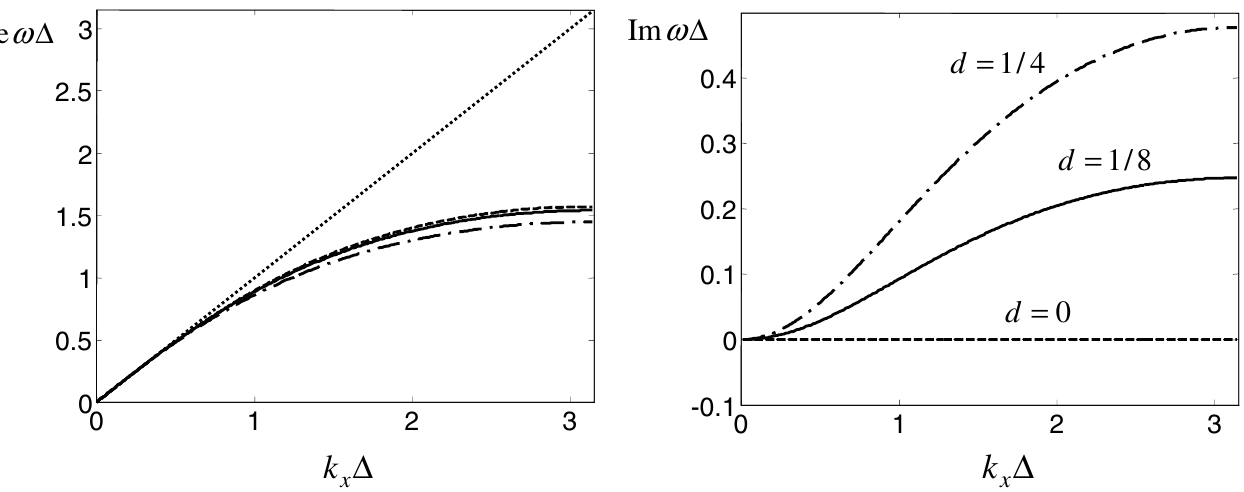
(cid:4) (cid:5) (cid:1) 1 ; 0 ; 0 (cid:4) direction. The left-hand figure shows the dispersion curve for ; k ; k x y z